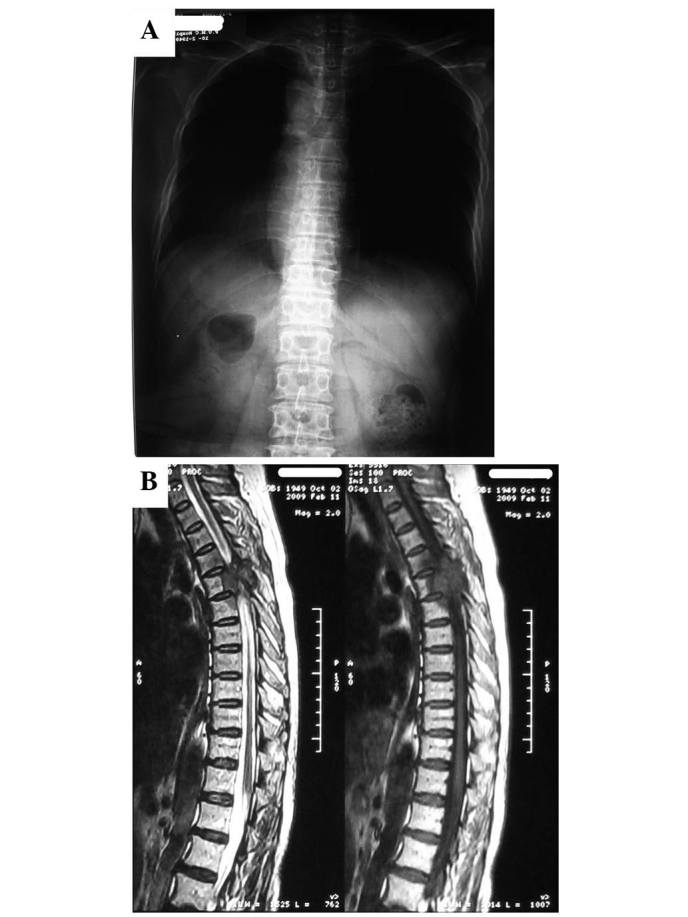
Image examination result of a tumor in the spine. (A) Lateral X-Ray of the thoracic spine of a patient with a thoracic vertebral metastatic tumor (lung cancer), with the lesion located at T4 and T5; (B) magnetic resonance imaging of the thoracic spine showed the vertebral metastatic tumor.